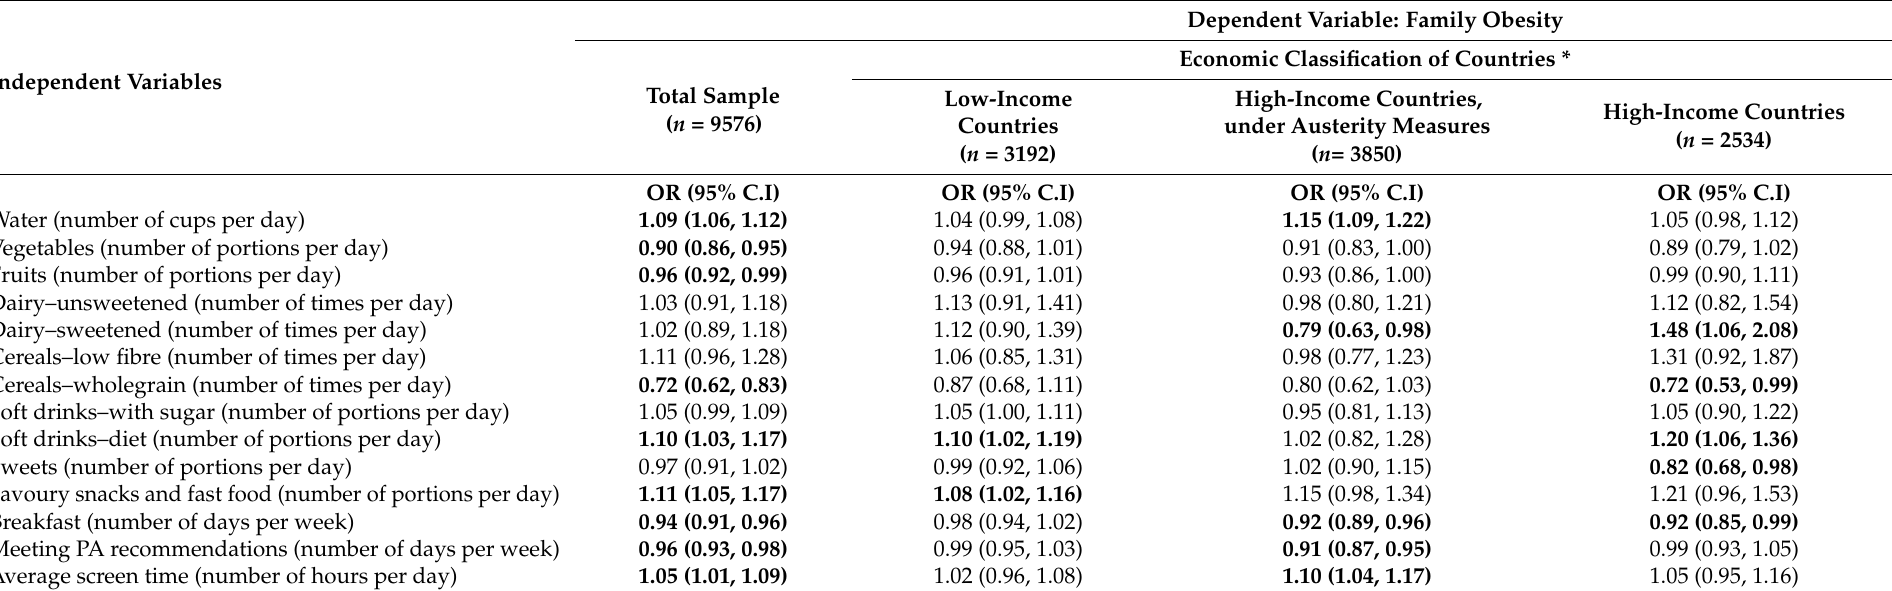
Table 4. Univariate logistic regression analyses examining the associations between lifestyle factors and family obesity for the total sample and by country’s economic